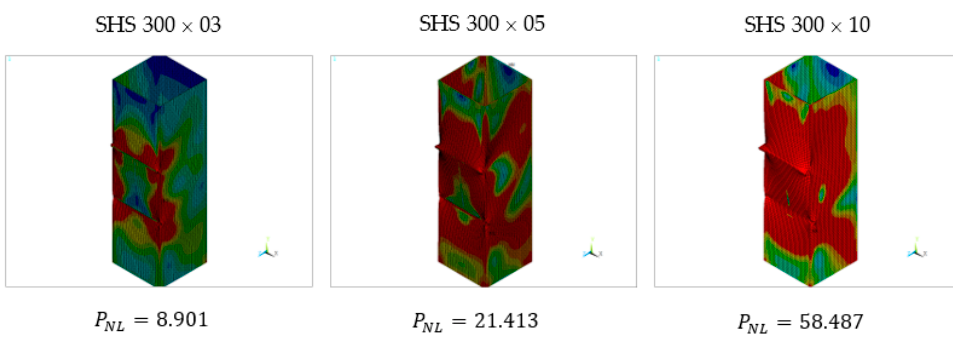
Figure 8. Von-Mises stress distribution at maximum load capacity. Table 2. Maximum crane loads of SHS columns with uniform external stiffeners.